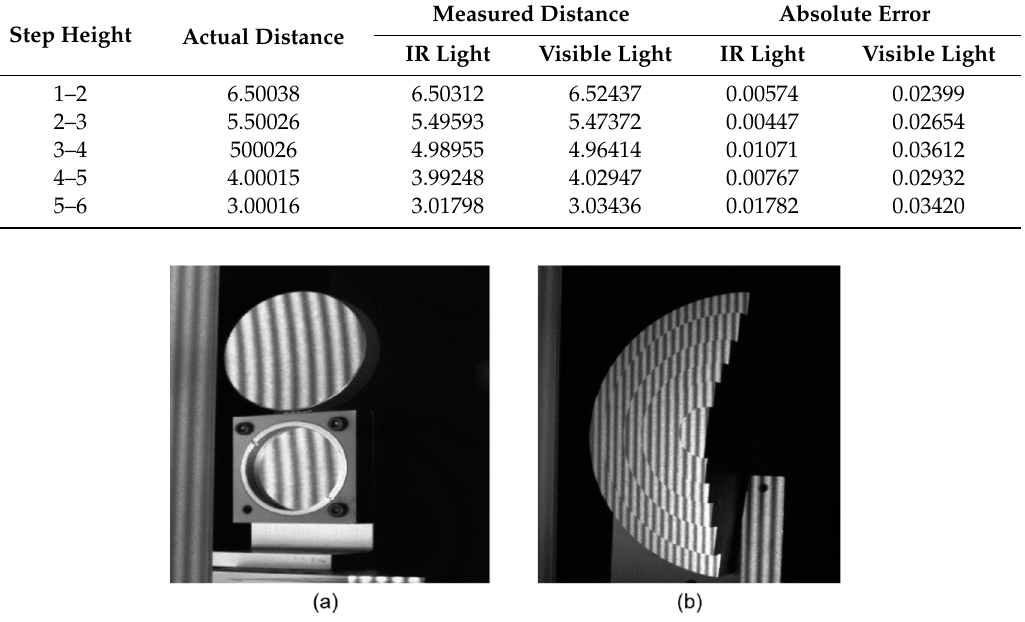
Figure 10. Captured fringe patterns of the measured specular objects. ( a ) Two separate specular objects; ( b ) Discontinuous fan-shaped mirror step.